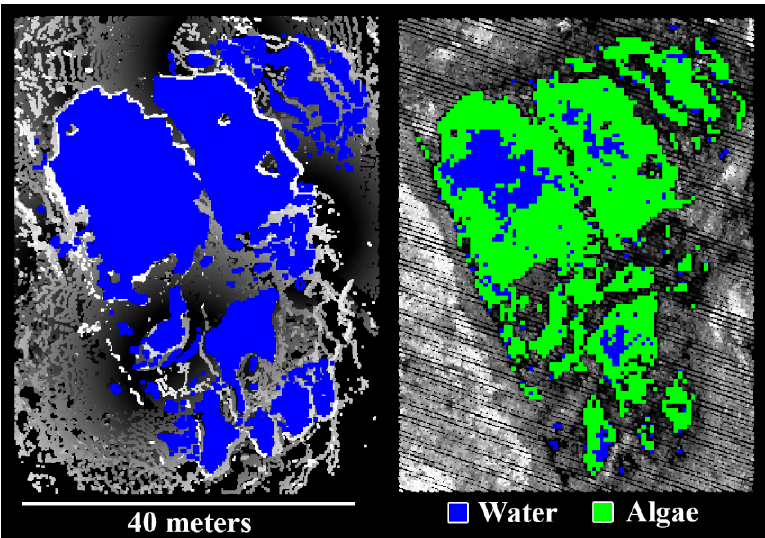
Figure 13 . Terrestrial lidar point cloud (far left), and representation of geomorphology (middle left, 0.25 m resolution) used a baseline for estimating Spartina alterniflora vegetation height from terrestrial (middle right, 0.25 m resolution) and airborne lidar (far right, 0.75 m resolution).